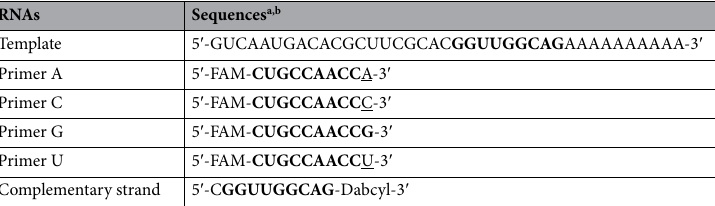
Table 1. Sequences of RNA template and RNA primers. a Bold font indicates complementary regions of template and primers. b Underline of the primers indicates mismatched bases to template